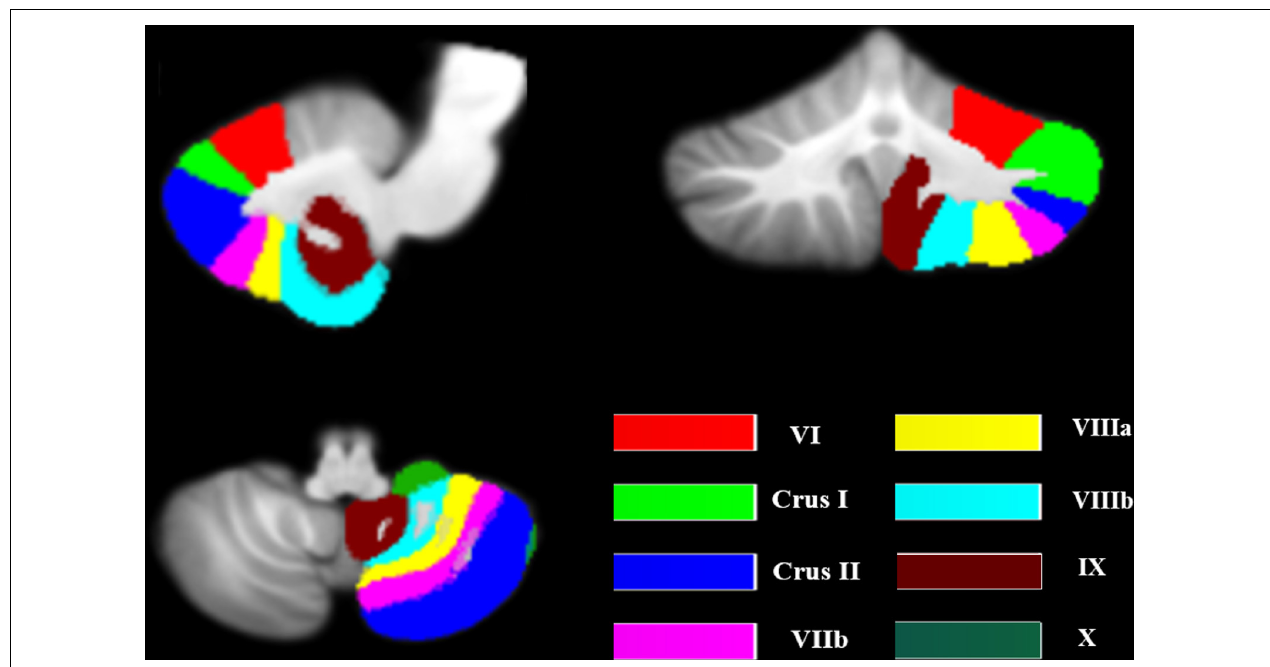
FIGURE 1 | The seeds of the cerebellum. The image was transformed into the space of the SUIT atlas and was overlapped by the seeds. The different colors show the lobular parcellation.